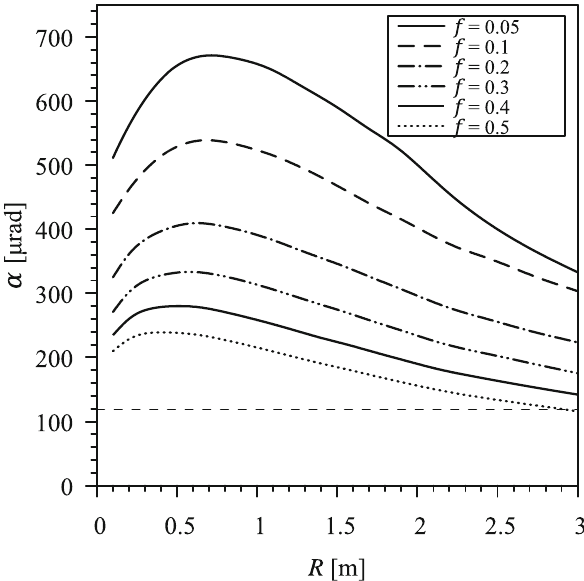
Fig. 4 Dependence of the maximum deflection angle of of antiprotons with a kinetic energy of 14 GeV on the bending radius of the crystal in case of stochastic